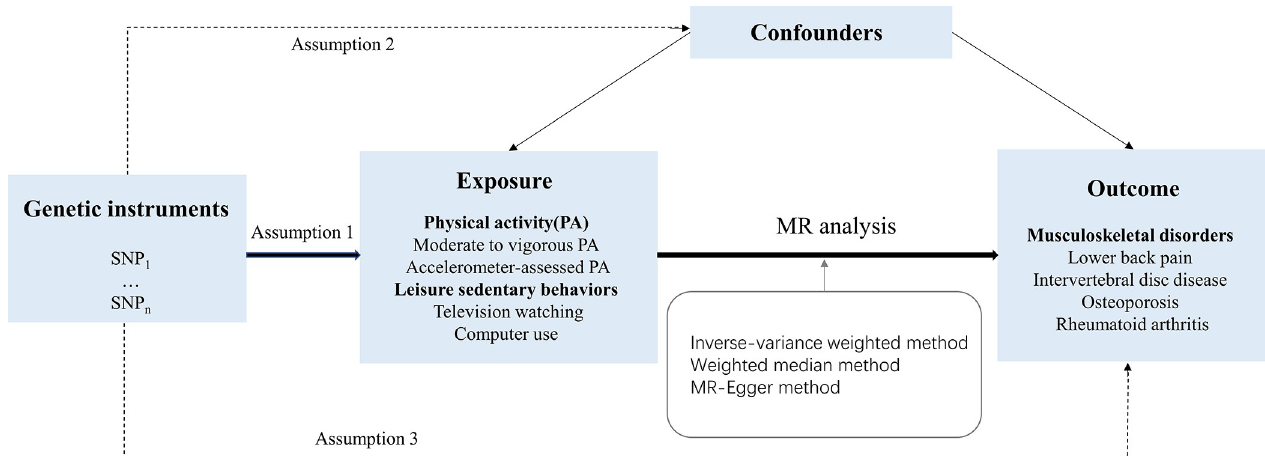
Fig 1. Study design